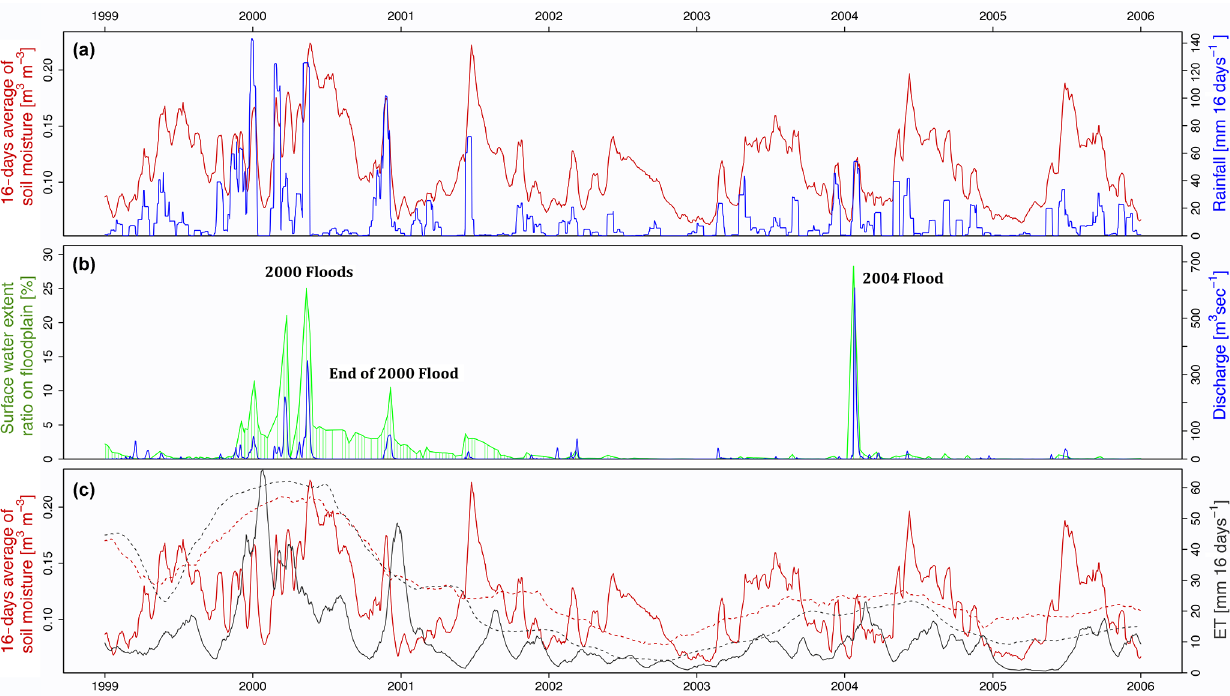
Figure 9. Relationship of variables used for modeling the floodplain area of the Paroo example cell Ex-A (location shown in Fig. 3) for the period from 1999 to 2006: (a) soil moisture and local rainfall, (b) discharge and surface water extent ratio, and (c) soil moisture and evapotranspiration with respective trend components (dashed